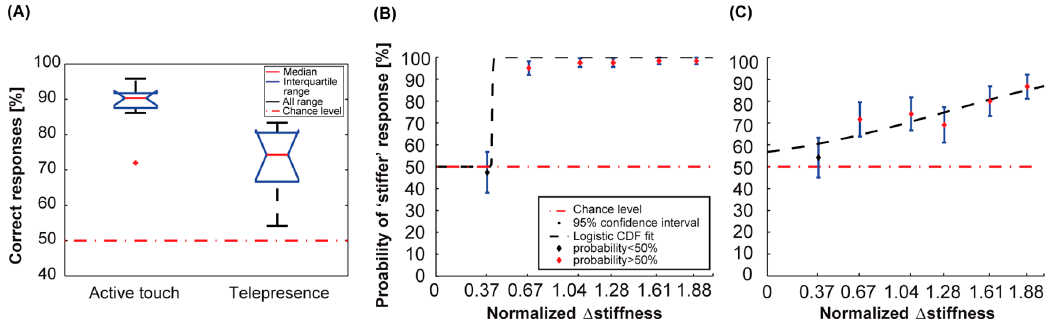
Figure 5. Psychophysics results of telepresence experiments. ( A ) Boxplot of correct responses for the two experimental conditions. Boxes represent interquartile range and black dashed lines show the complete range across participants. The red dashed line represents chance level; ( B ) Psychometric curve for the benchmarking psychophysics experiments with active touch. Each dot represents the fraction of times each stimulus was classified as having increasing stiffness (median across participants). If the identification rate is significantly different (probability of success > 50%, binofit test) from chance (50%) the dot is red, otherwise it is black. Error bars indicate the 95% confidence interval across participants and the red horizontal line represents chance. Black dashed line represents the logistic cumulative distribution function (CDF) fit; ( C ) Same as ( B ) for the psychophysics experiments in telepresence.